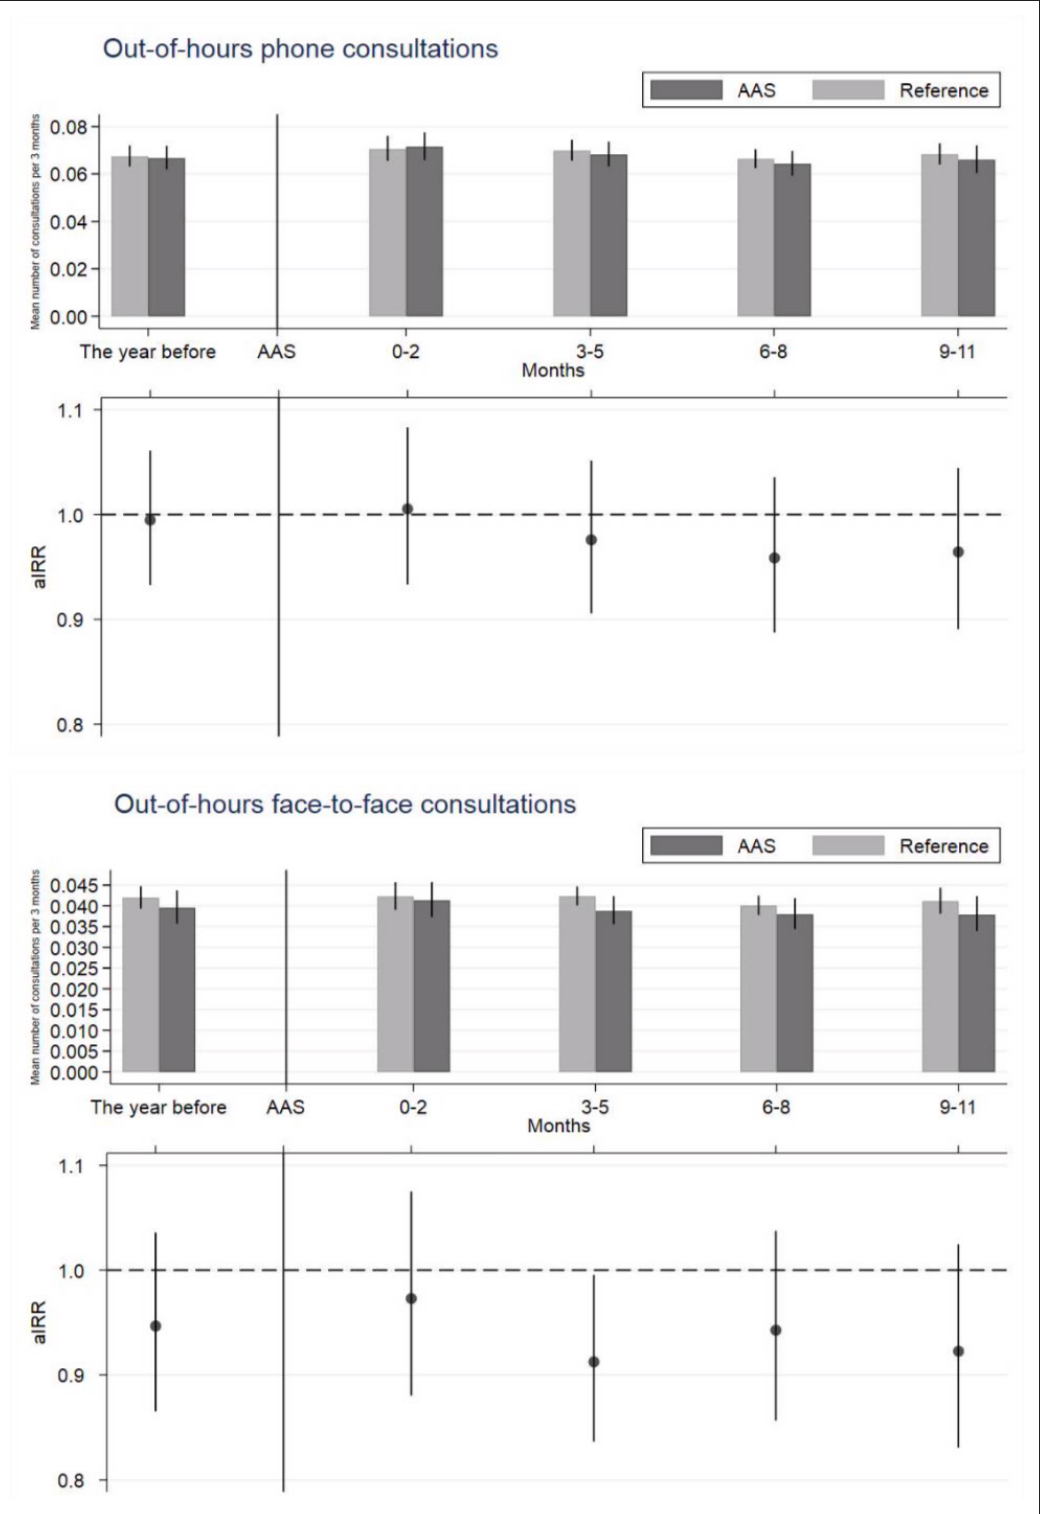
Figure 2 Out- of- hours face- to- face and phone consultations 1 year before and 1 year after the index date. The vertical line marks the index date. Upper part: mean number of consultations per patient per 3 months with 95% confidence intervals (CIs) for patients listed with advanced access scheduling (AAS) practices and reference practices. Lower part: adjusted incident rate ratios (aIRRs) with 95% CIs adjusted for sex, age, vital status, ethnic